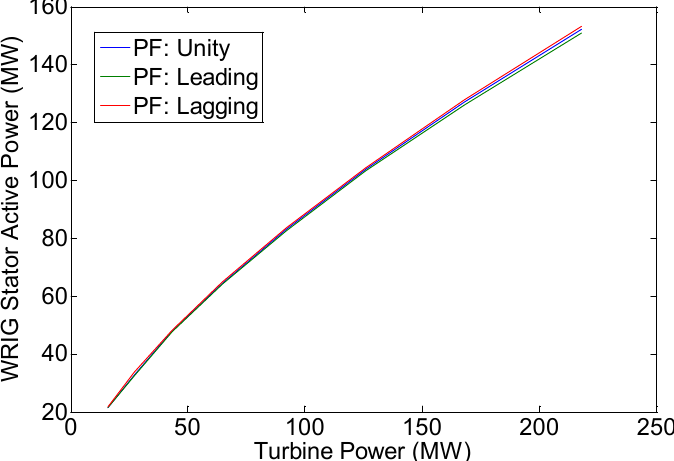
Figure 6. Variation of WRIG stator power ( P S ).